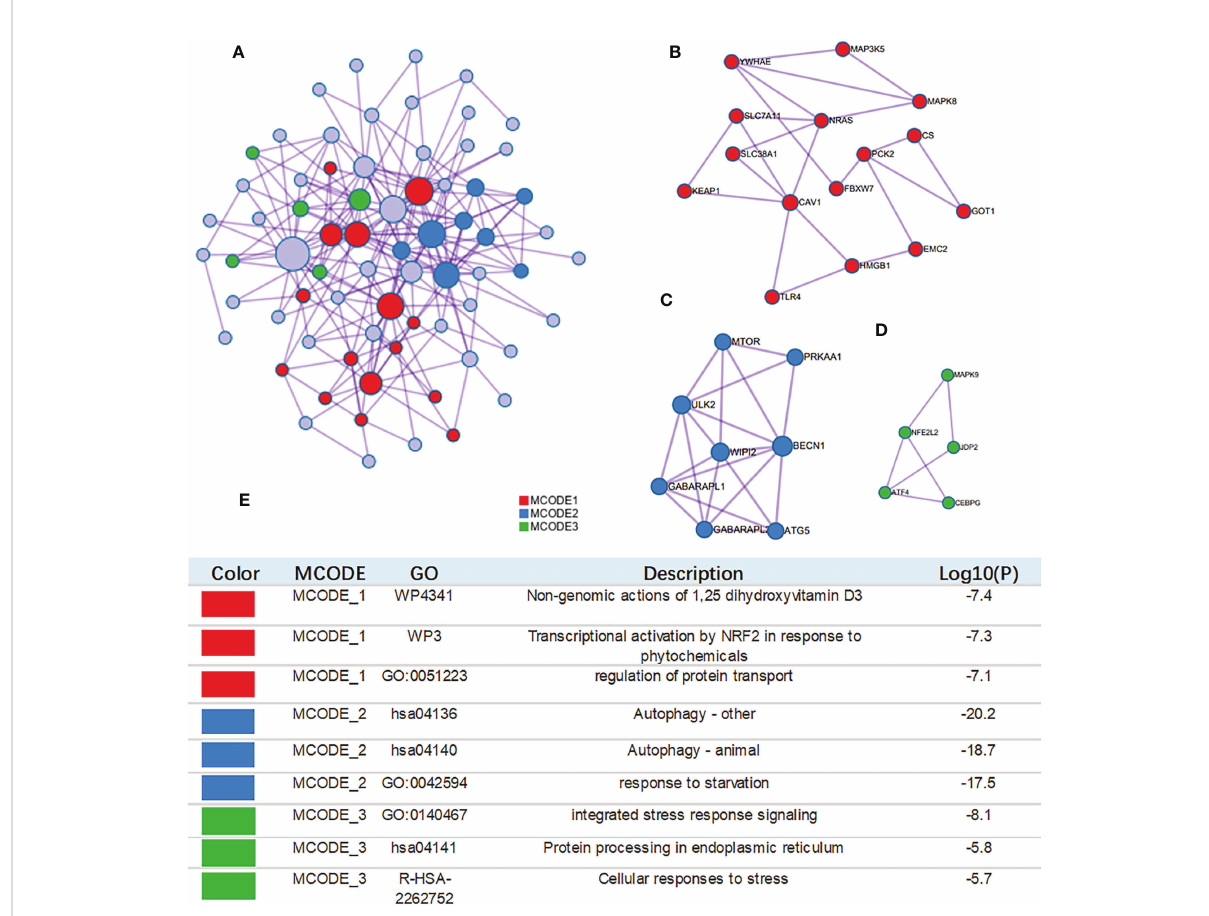
FIGURE 4 Construction of interactive network. (A) GO enrichment analysis was applied to each MCODE network. The same color nodes represent an interactive network and perform similar biological functions. (B – D) Three MCODE components were constructed with the screened hub genes. (E) Details of the 3 clusters were shown in